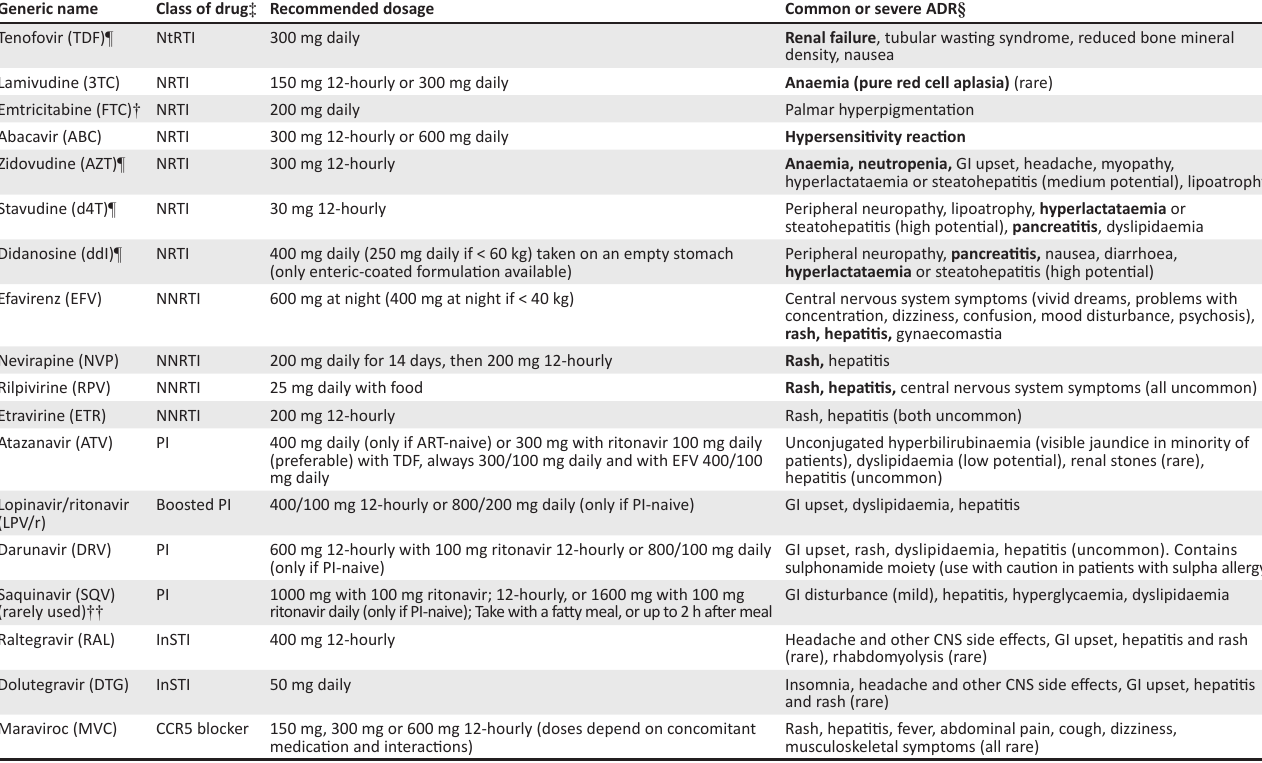
TABLE 2: Dosage and common adverse drug reactions of antiretroviral drugs available in southern Africa. Generic